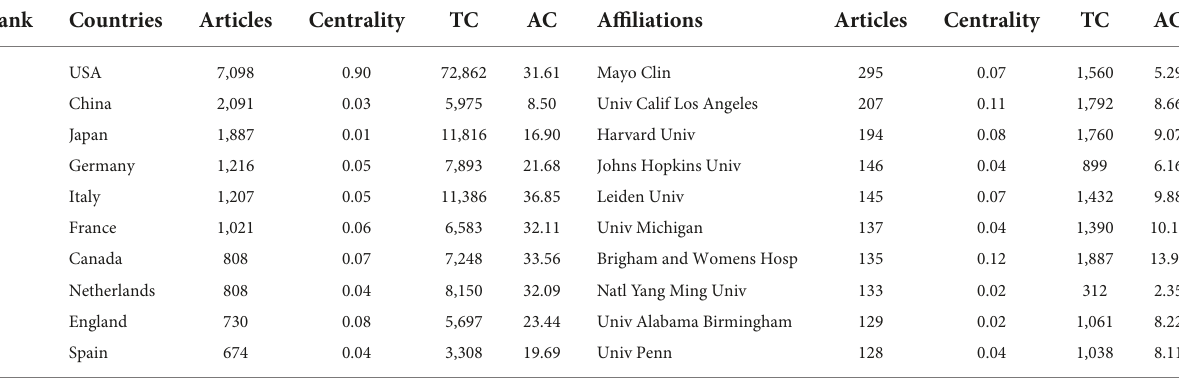
TABLE 2 The top 10 most active countries and affiliations contributing to scientific production in ventricular arrhythmia (ordered by articles count).